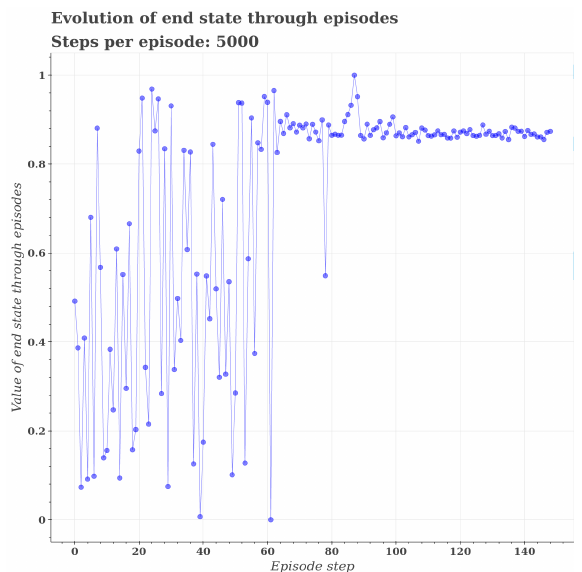
Figure 9. State of the agent at the end of each of the 150 episodes for the averaging function. After the exploration phase, around episode 70 the agent reaches a value near 0.87, which is similar to the solution provided by the evolutionary